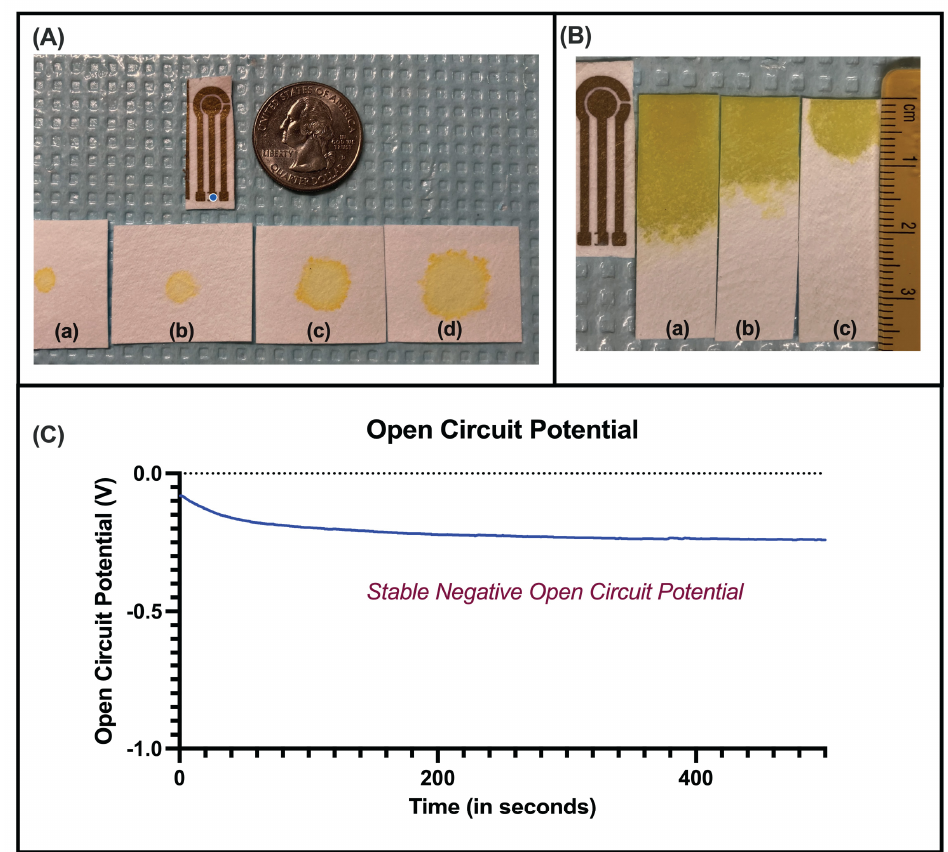
Figure 2. ( A ) Fluid wicking analysis to optimize fluid volume to cover working and counter electrode area for antibody immobilization and urine buffer dispensing. Fluid was dispensed on the substrate in increasing volumes ( a ) 0.5 µ L, ( b ) 1 µ L, ( c ) 2 µ L, and ( d ) 5 µ L. ( B ) Fluid wicking study in down-web direction to optimize sensor strip length ( a ) 60 µ L, ( b ) 30 µ L, and ( c ) 10 µ L. ( C ) Open circuit potential measurement to establish stability of the developed sensor in urine buffer prior to PGE2